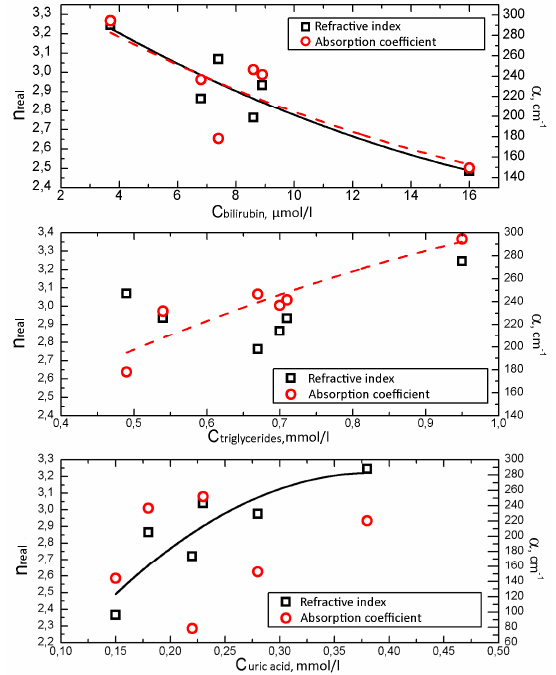
Fig. 3. In a number of cases there is possible to observe as blood optical properties in THz frequency range (such as refractive index and absorption coefficient) depend on con- centrations of blood components.